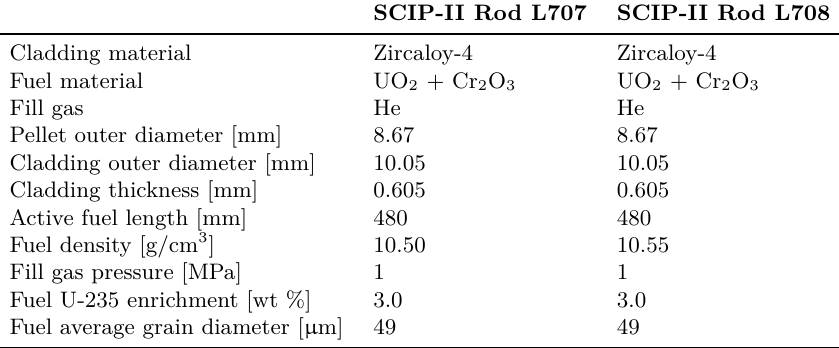
Table 4. Fuel characteristics of SCIP-II rod L707 and L708 simulated in this thesis.